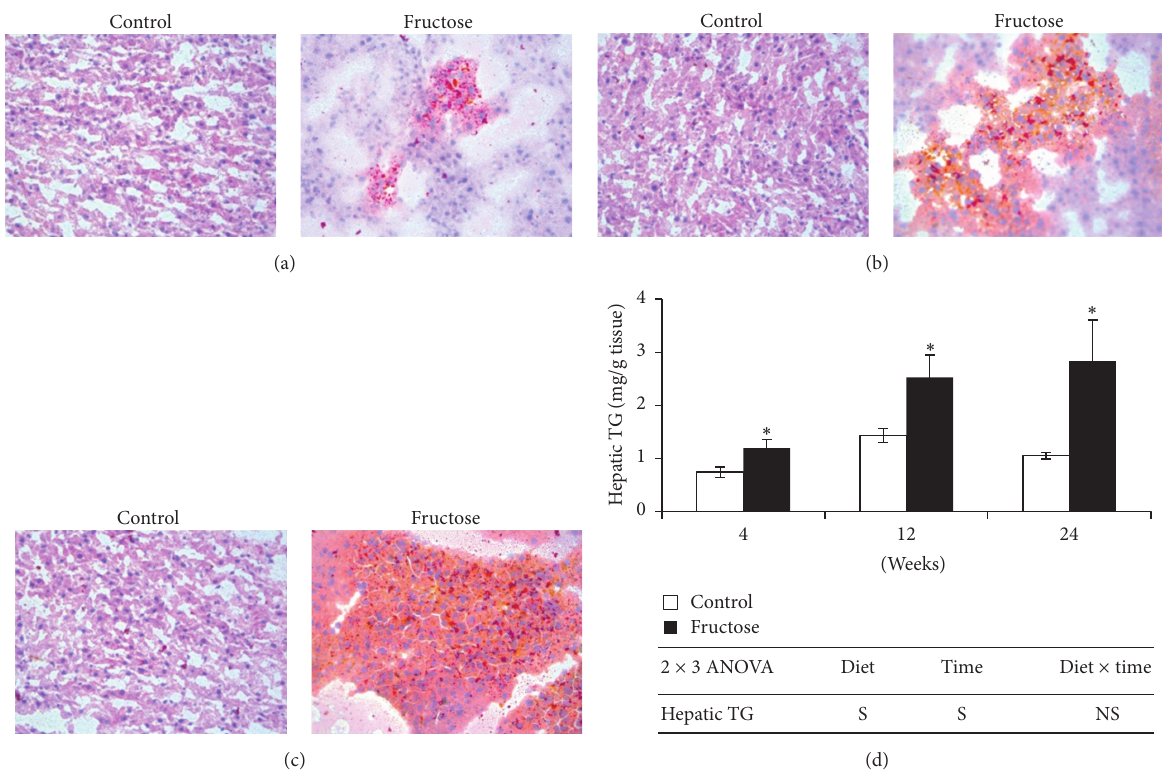
Figure 1: Oil red O staining of control and fructose diet-fed rat livers (400x magnification). (a) 4 weeks. (b) 12 weeks. (c) 24 weeks. (d) Hepatic lipids. Values are in mean ± SE of 8 animals from each group at all time points. ∗ Significance at 𝑝 ≤ 0.05 by Student’s 𝑡 -test. Statistical significance of diet, time, and diet ∗ time on individual parameters is also analyzed by two-way ANOVA. “S” indicates “significant” ( 𝑝 ≤ 0.05 ); “NS” indicates “not